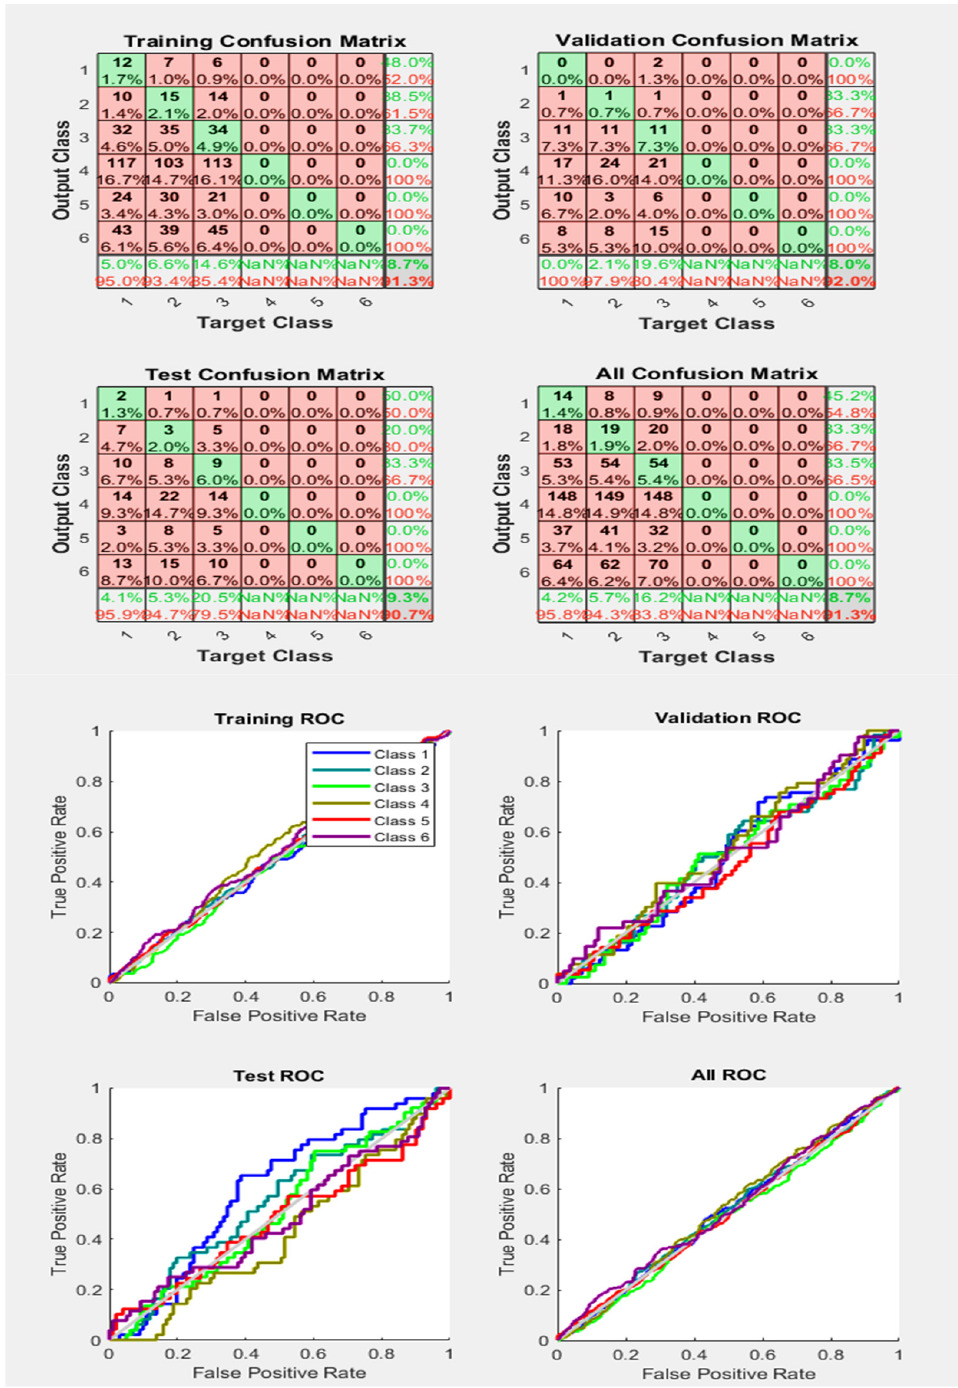
Figure 23. Neural Network Model ROC (Receiver Operating Characteristics) and Confusion Matrix for CGP TrainFcn/Activation Function at level 9 (RMS) Features for Rotor Bar Fault with 91.3% Accuracy. Grey line shows diagonal of the ROC for indicating Class 1–6 lines are lying above or below or on it.